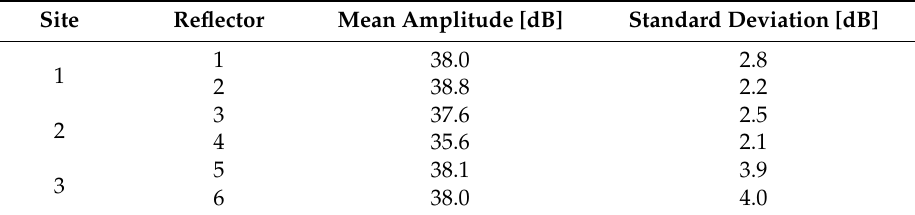
Table 2. Mean amplitude value and standard deviation of the amplitude for the measurement period. The higher variation at Site 3 is believed to be caused by the longer distance, which gives a greater susceptibility to atmospheric attenuation.